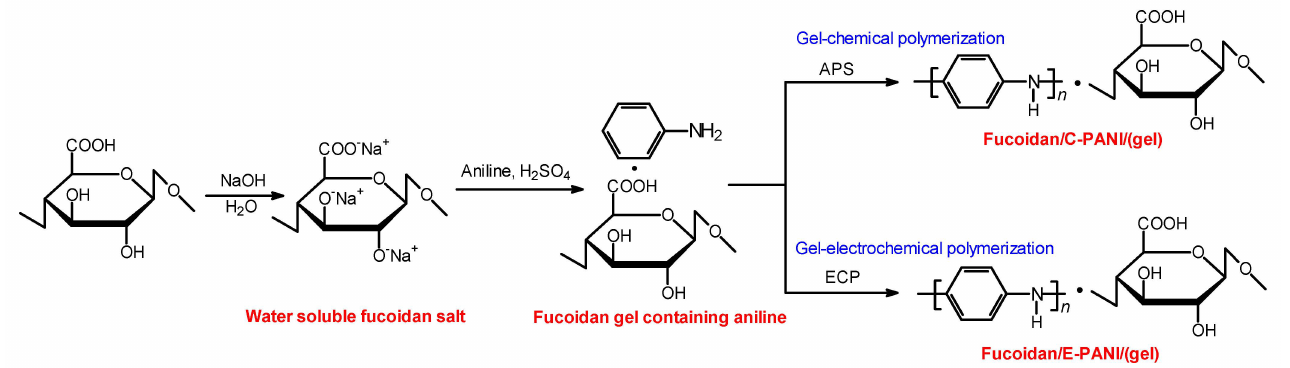
Table 2. Polymerization of aniline in the presence of fucoidan with oxidative chemical polymer- ization and electrochemical polymerization a . C-PANI, pure PANI prepared by chemical oxidative polymerization; fucoidan/C-PANI(gel), a composite prepared in the gel by chemical oxidative poly- merization; E-PANI, pure PANI prepared by electrochemical polymerization; fucoidan/E-PANI(gel), a fucoidan/PANI composite prepared in the fucoidan gel by electrochemical polymerization. Fucoidan (g) APS (g) b E (V) c T d Product C-PANI - 0.6 - 24 h Powder (0.214 g) Fucoidan/C-PANI(gel) 0.5 Fucoidan/E-PANI(gel)